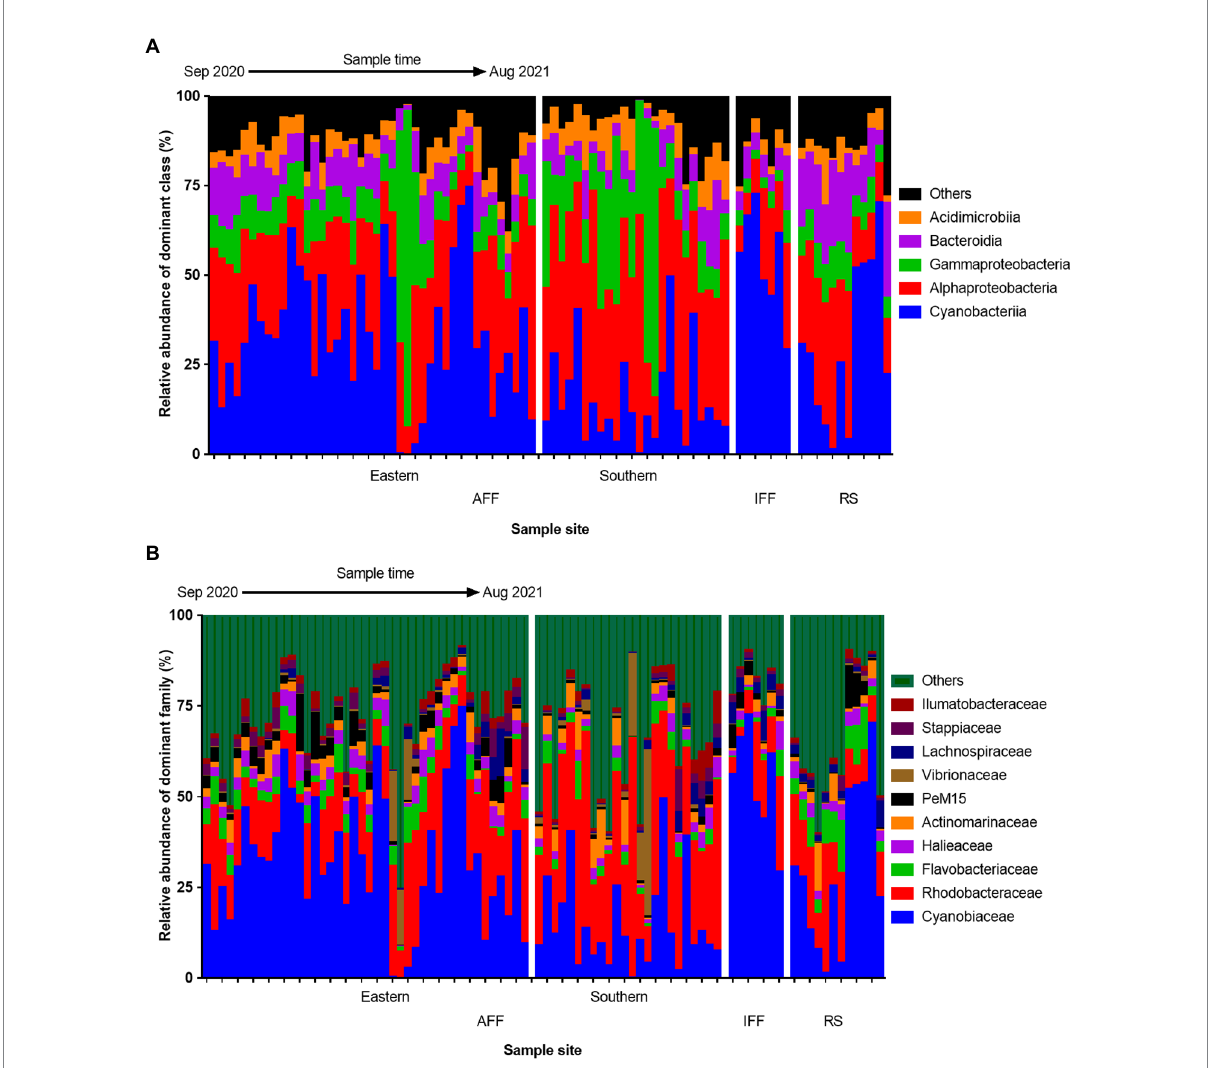
FIGURE 3 Spatiotemporal variation in bacterial community compositions at (A) class and (B) family levels among Hong Kong coastal waters. All samples were grouped based on their geographic location in Hong Kong and sub-ordered by sampling time from September 2020 to August 2021. AFF, active fish farms; IFF, inactive fish farms; RS, open water reference